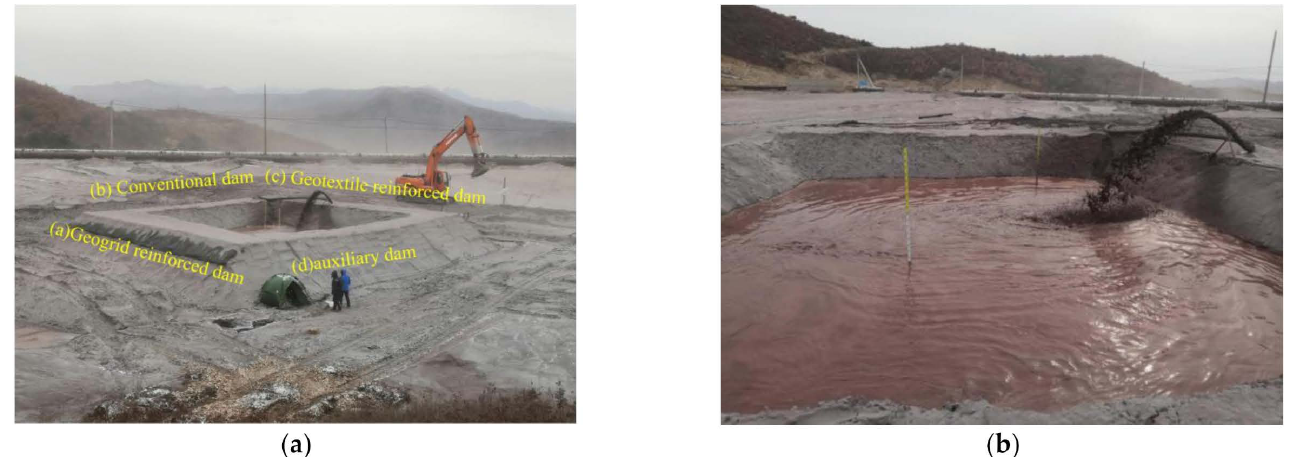
Figure 6. Completion of the overall piling of the reinforced tailings dam and data collection: ( a ) test dam; ( b ) water level observation.